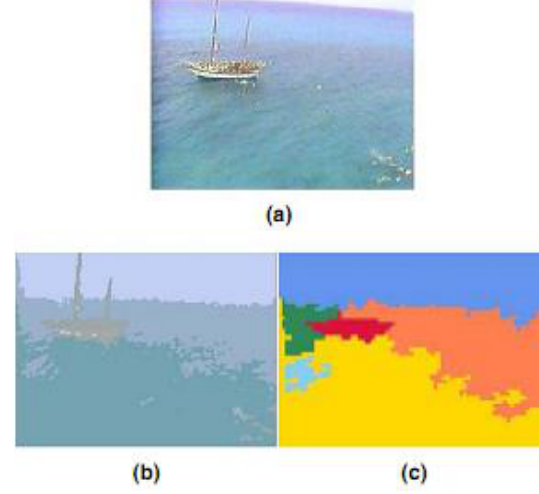
Figure 18. (a) Original image (b) This work’s segmentation (c) Reference 10’s segmentation.